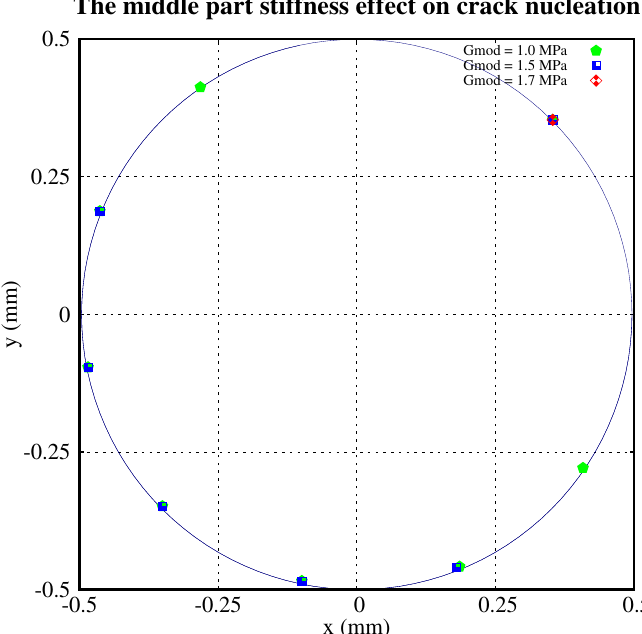
Figure 7. Crack nucleations with different stiffnesses of the middle part. Figure 8 is the chemical potential distribution within the crack with different time steps. The nucleation process shows a cascade phenomenon (Figure 8). At the time of 4.8 s, the initial crack propagates without any nucleation. After 0.1 s, there is one nucleation. Another new crack nucleated after 0.1 s. At the time of 5.1 s, the previous two nucleations kept growing, and another three new cracks were